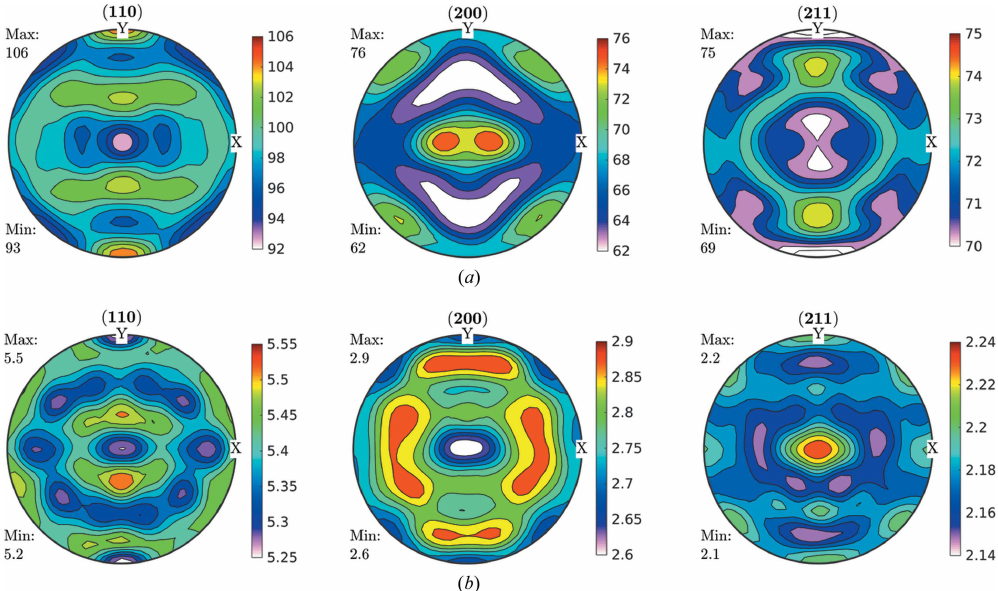
Figure 12 Recalculated GPFs for ( a ) domain size (nm) and ( b ) dislocation density (10 14 m (cid:3) 2 ), as separated by following the Langford model from FWHM GPFs. Heat-treated sample, 5 s at 600 (cid:6)